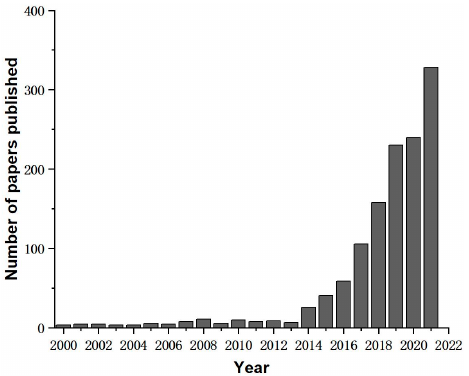
Figure 1. Publication of articles using 3D printing for thermal conductivity studies from 2000 to 2021. Source: Web of Science.